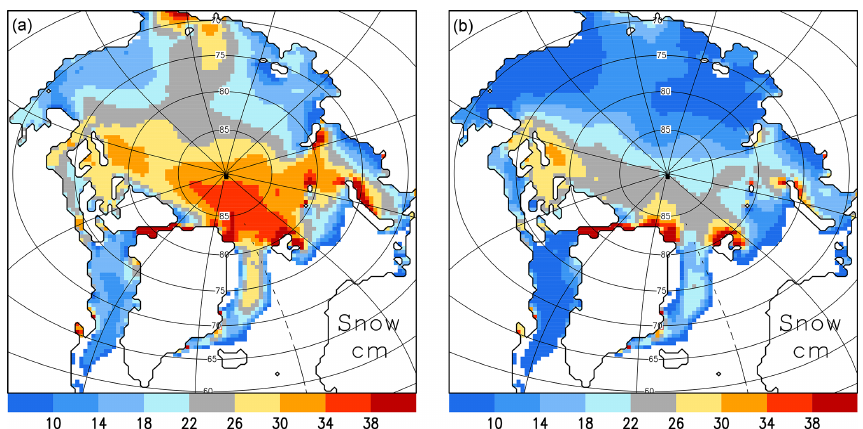
Figure 7. Impact of snow erosion on simulated mean April snow depth (2010 to 2017): (a) CICE-default and (b) CICE-mw-from-e-sd.